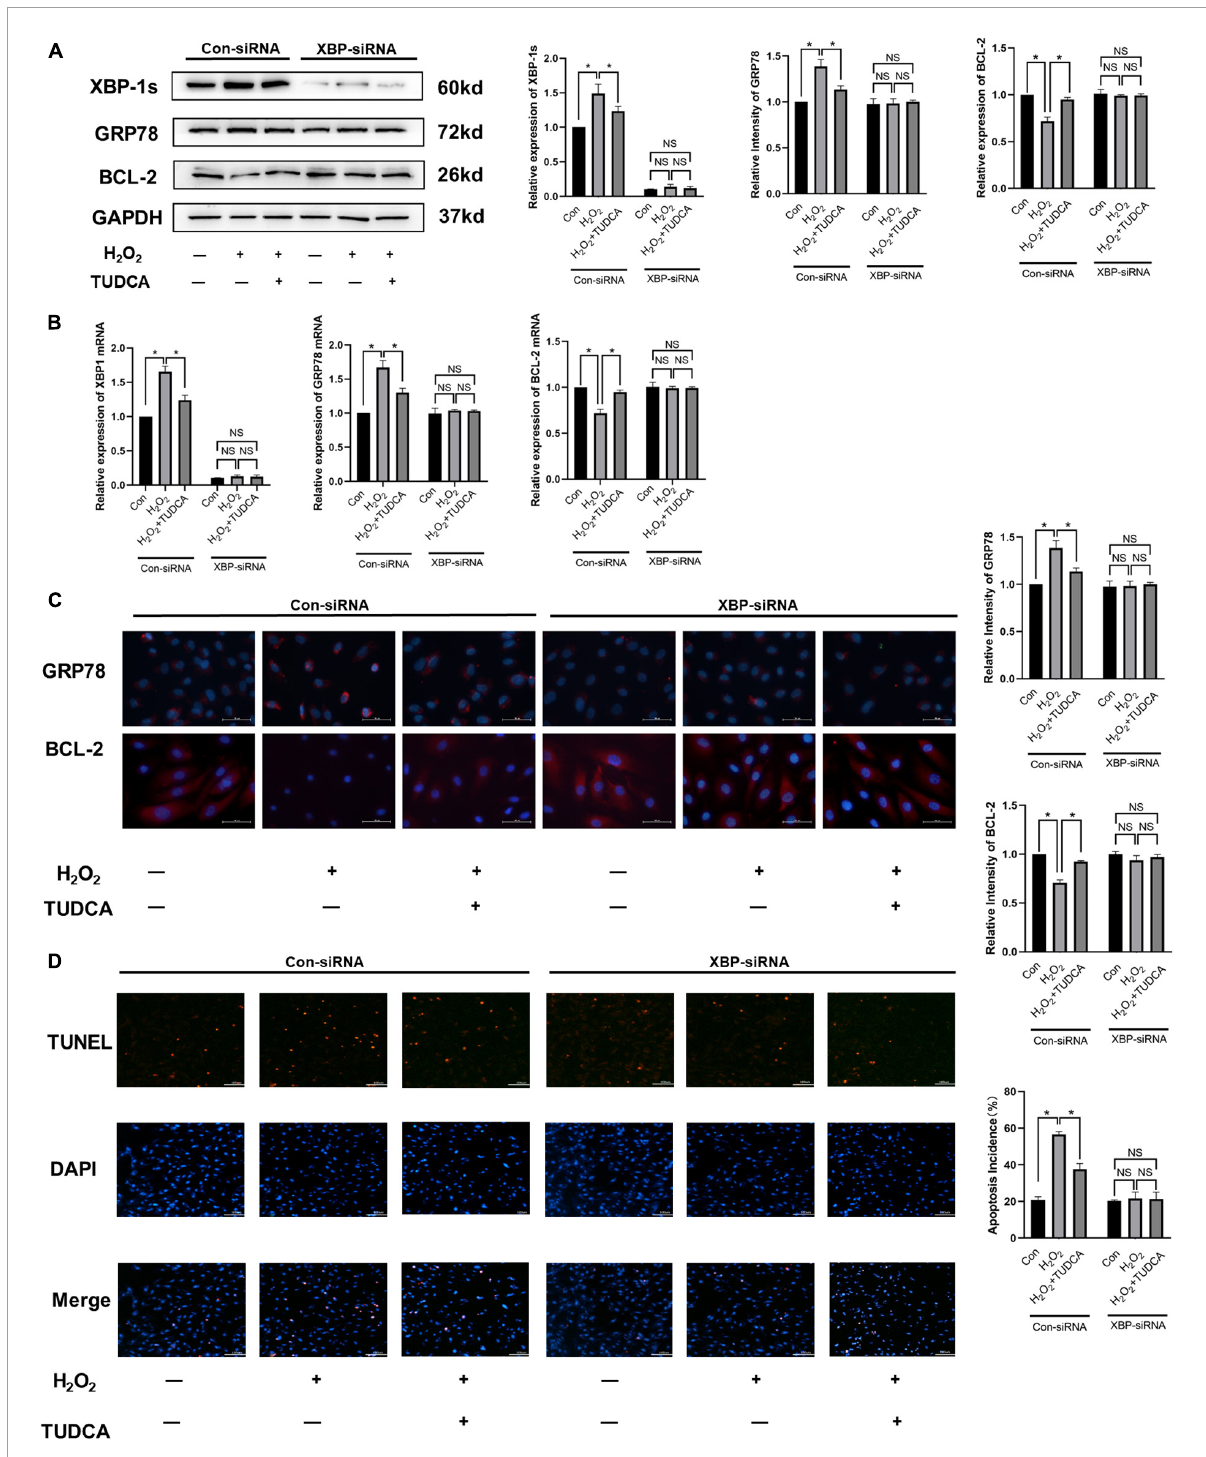
FIGURE5 Tauroursodeoxycholic acid (TUDCA) reduced apoptosis by inhibiting the IRE/XBP-1 pathway in vitro . (A) Western blotting was used to determine the expression levels of XBP-1s, GRP78, BCL-2. (* P < 0.05 n = 3). (B) mRNA expression of XBP-1s, GRP78, BCL-2. (C) Immunofluorescence was used to determine the expression levels of GRP78, BCL-2. (* P < 0.05, n = 3). (D) Effects of TUDCA and XBP1s in H 2 O 2 -induced apoptosis of HUVECs, as detected by TUNEL apoptosis detection. (* P < 0.05, NS: not statistically significant, n =